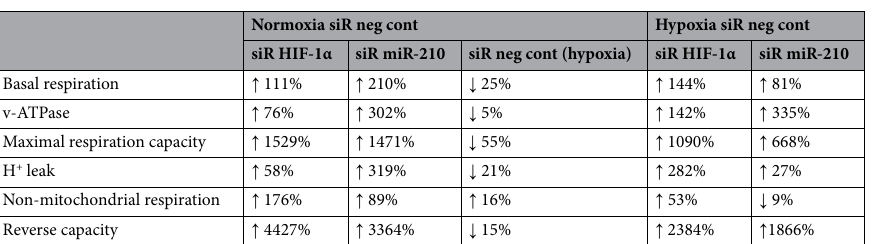
Table 2. Comparison of the OCR values to siR neg cont in normoxia for siR HIF-1α and siR miR-210. Comparison of the OCR values to siR neg cont in hypoxia for siR HIF-1α and siR miR-210 in hypoxia.